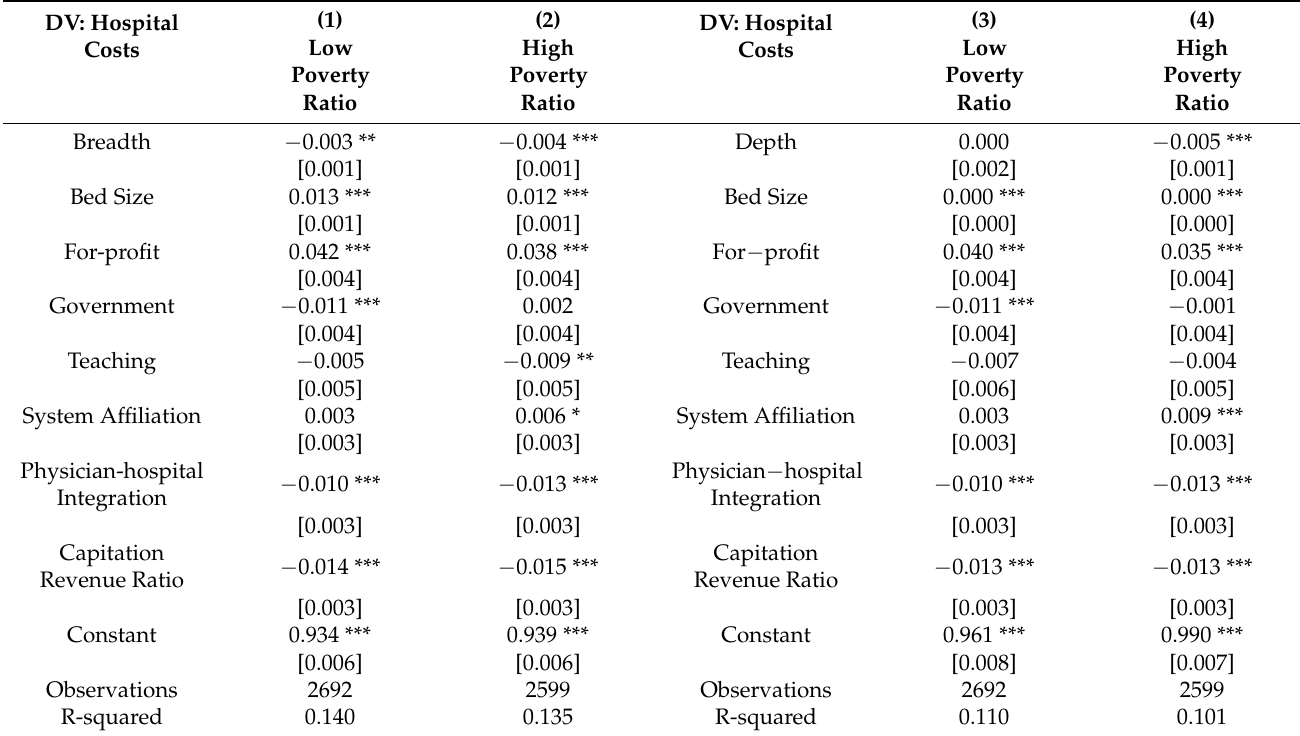
Table 3. The impact of health information sharing on spending by poverty